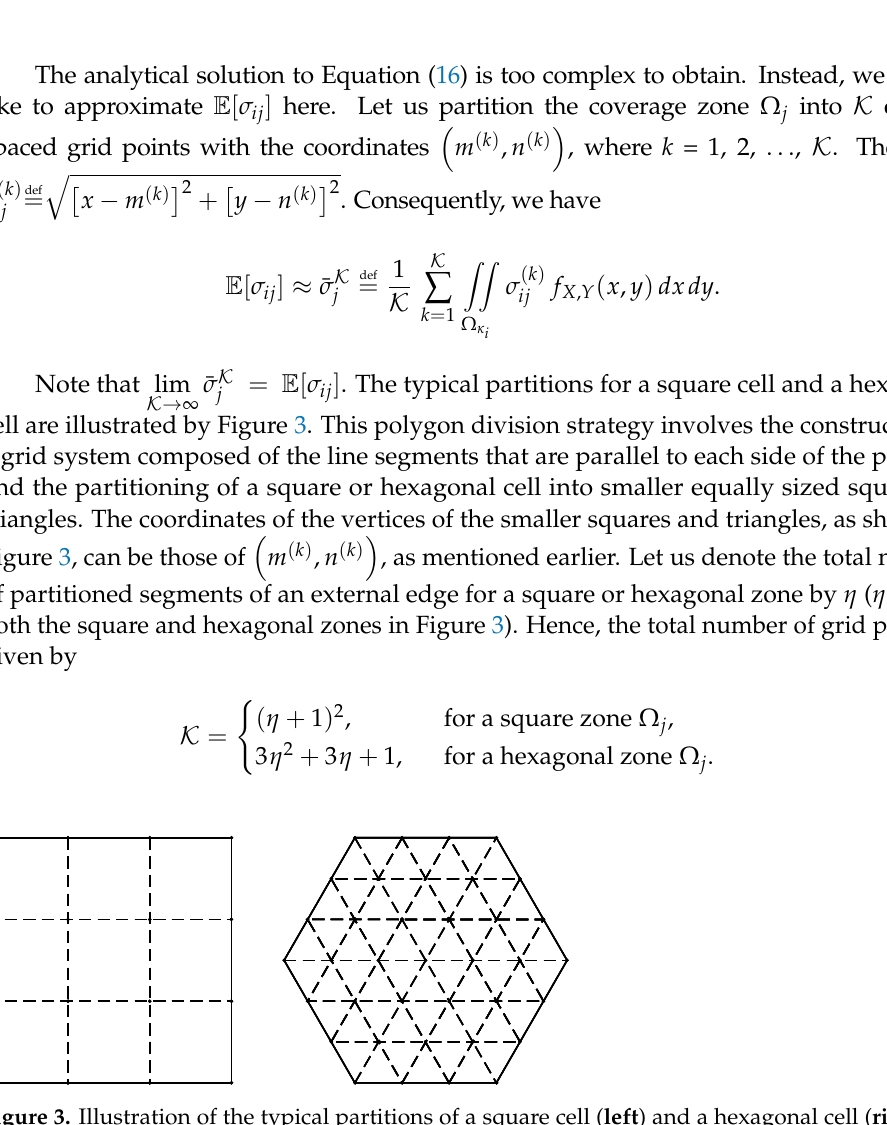
with respect to η for both square and hexagonal cells j